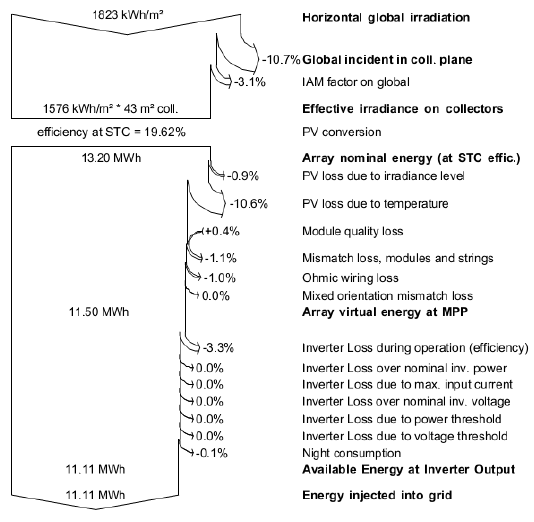
Figure 8. Loss diagram of the grid-connected PV system